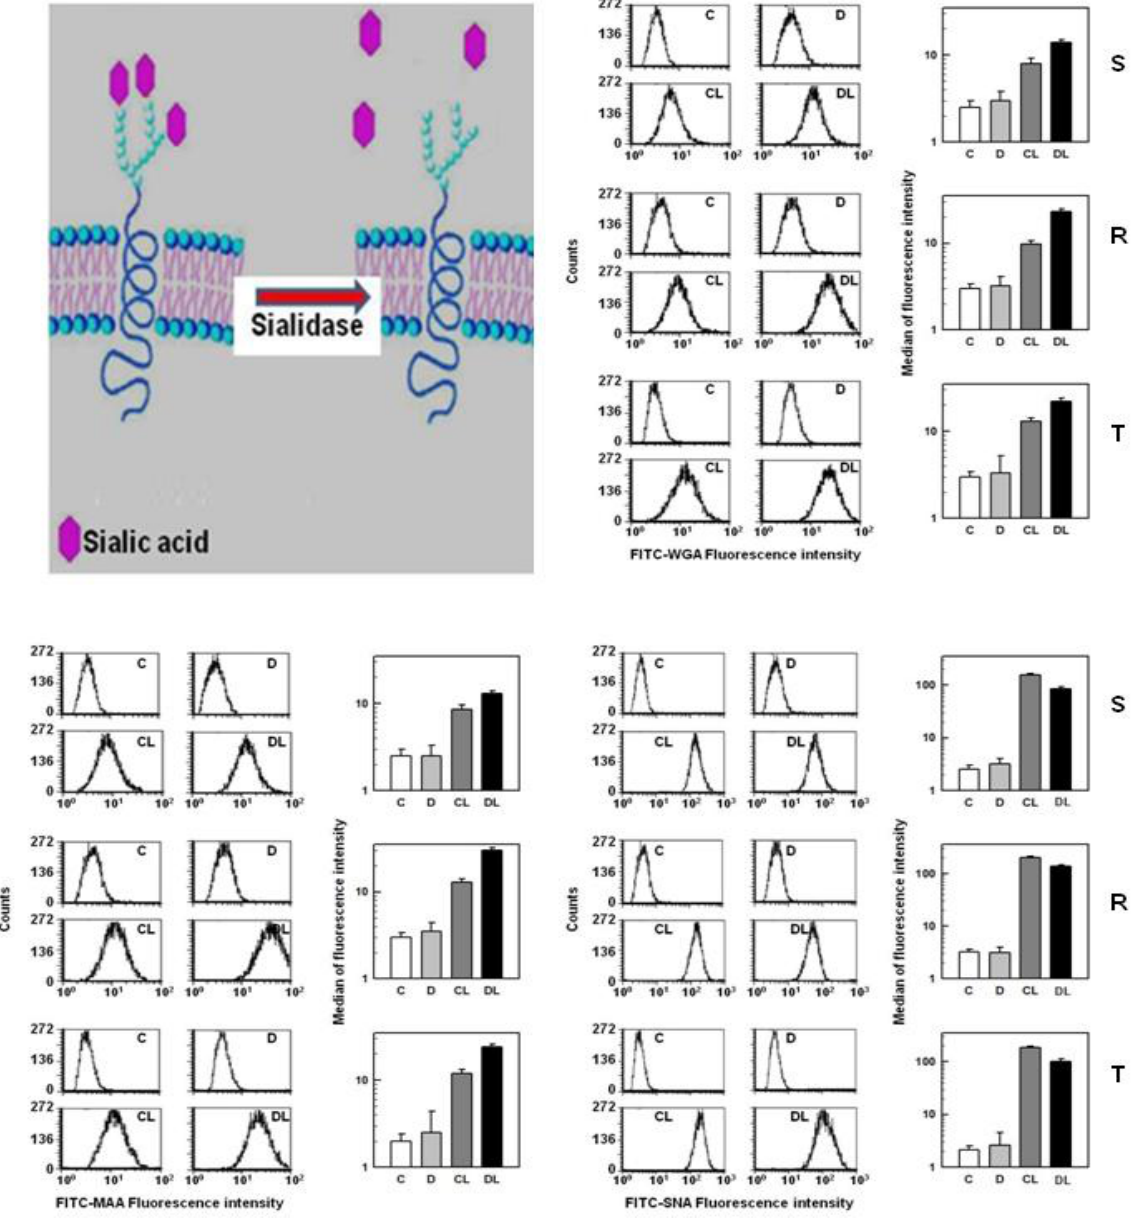
Figure 6. Effects of sialidase treatment on WGA, MAA and SNA binding to S, R and T cells. Sialidase-induced removal of external sialic acid is schematically shown in the upper left panel. Cells incubated in the absence (C) or presence (D) of sialidase were left to interact with FITC-WGA, FITC-MAA and FITC-SNA (CL and DL). Cells incubated in the absence of FITC labeled lectins (C, D) were used as control. FACS histograms are representative of three independent measurements. The median fluorescence intensity data represent the mean ± SD of three independent experiments. Differences between the median fluorescent intensity were significant when comparing CL and DL with the following probabilities for WGA binding to: S cells— p < 0.02, R cells— p < 0.01 and T cells— p <0.01; MAA binding to S cells— p < 0.02, R cells— p < 0.01 and T cells— p < 0.01; and SNA binding to S cells— p < 0.005, R cells— p < 0.01 and T cells— p <